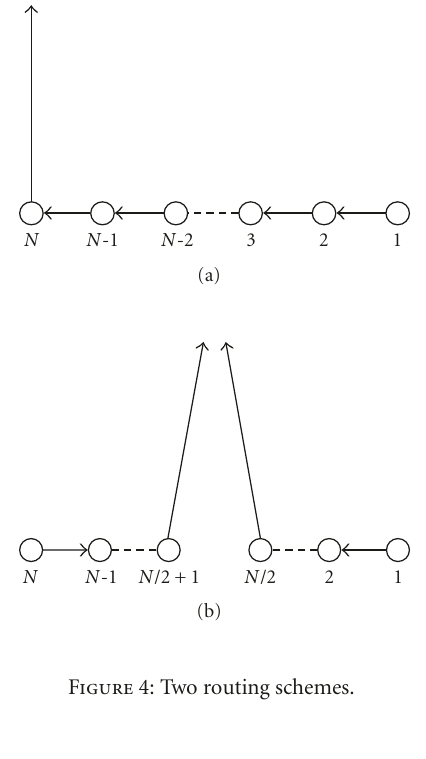
Figure 4: Two routing